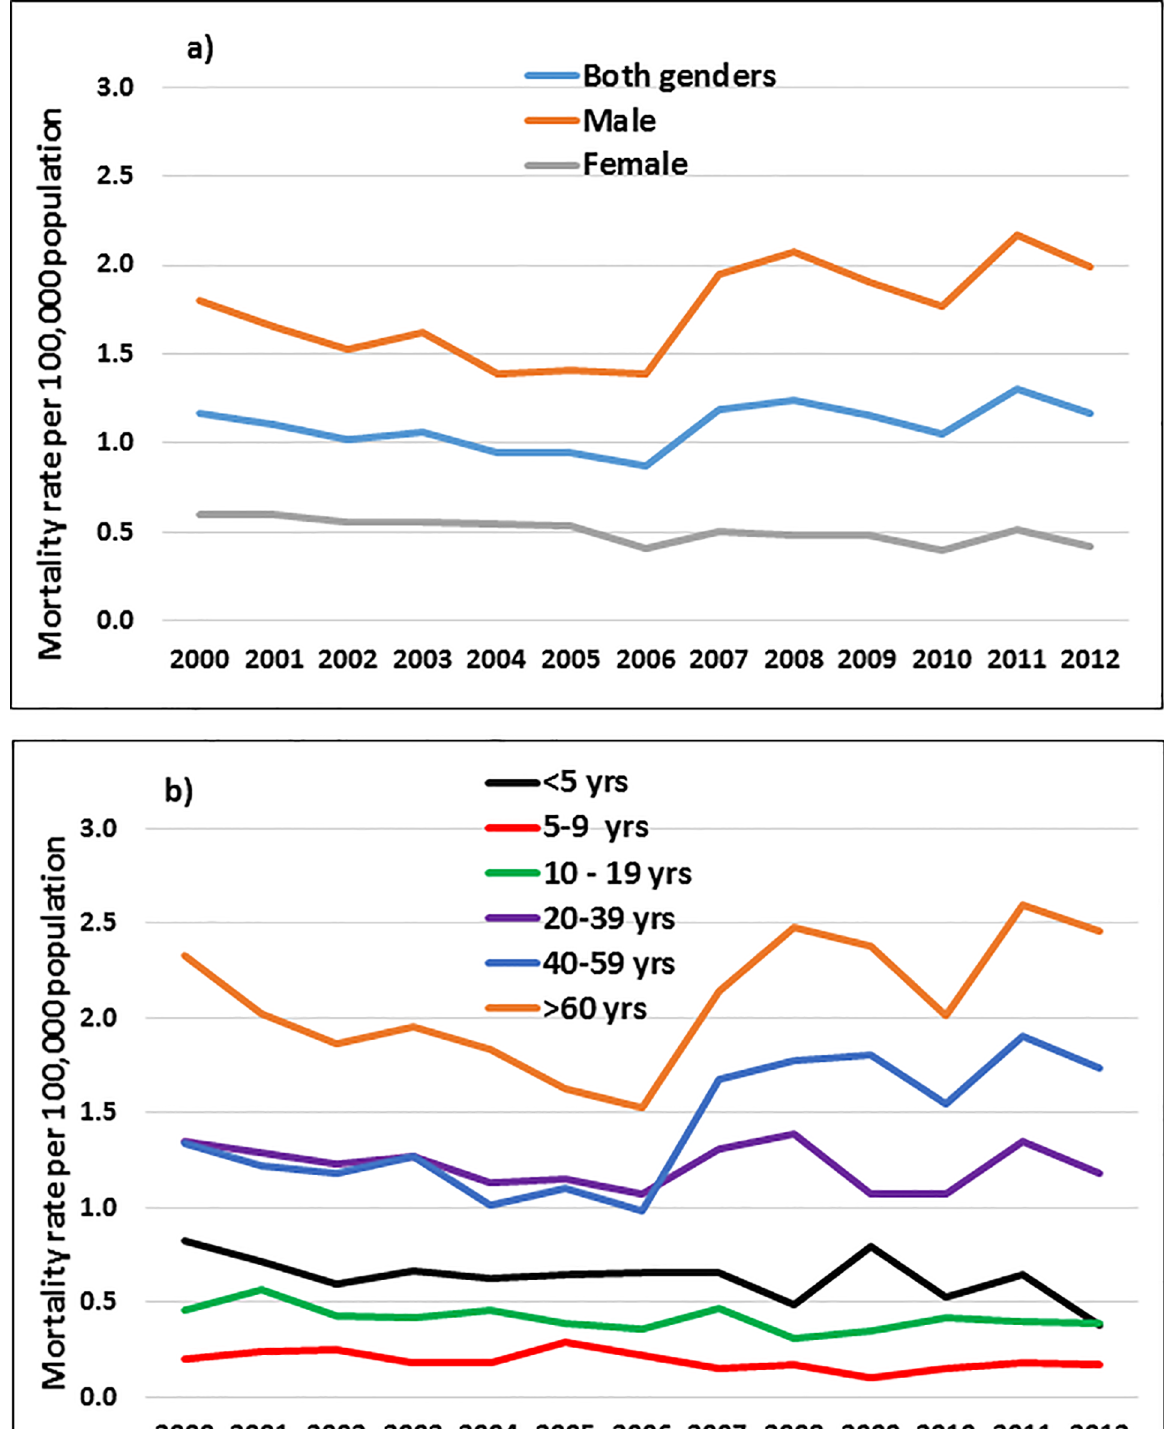
Fig 1. Unintentional poisoning mortality in Mexico by a) gender and b) age group.